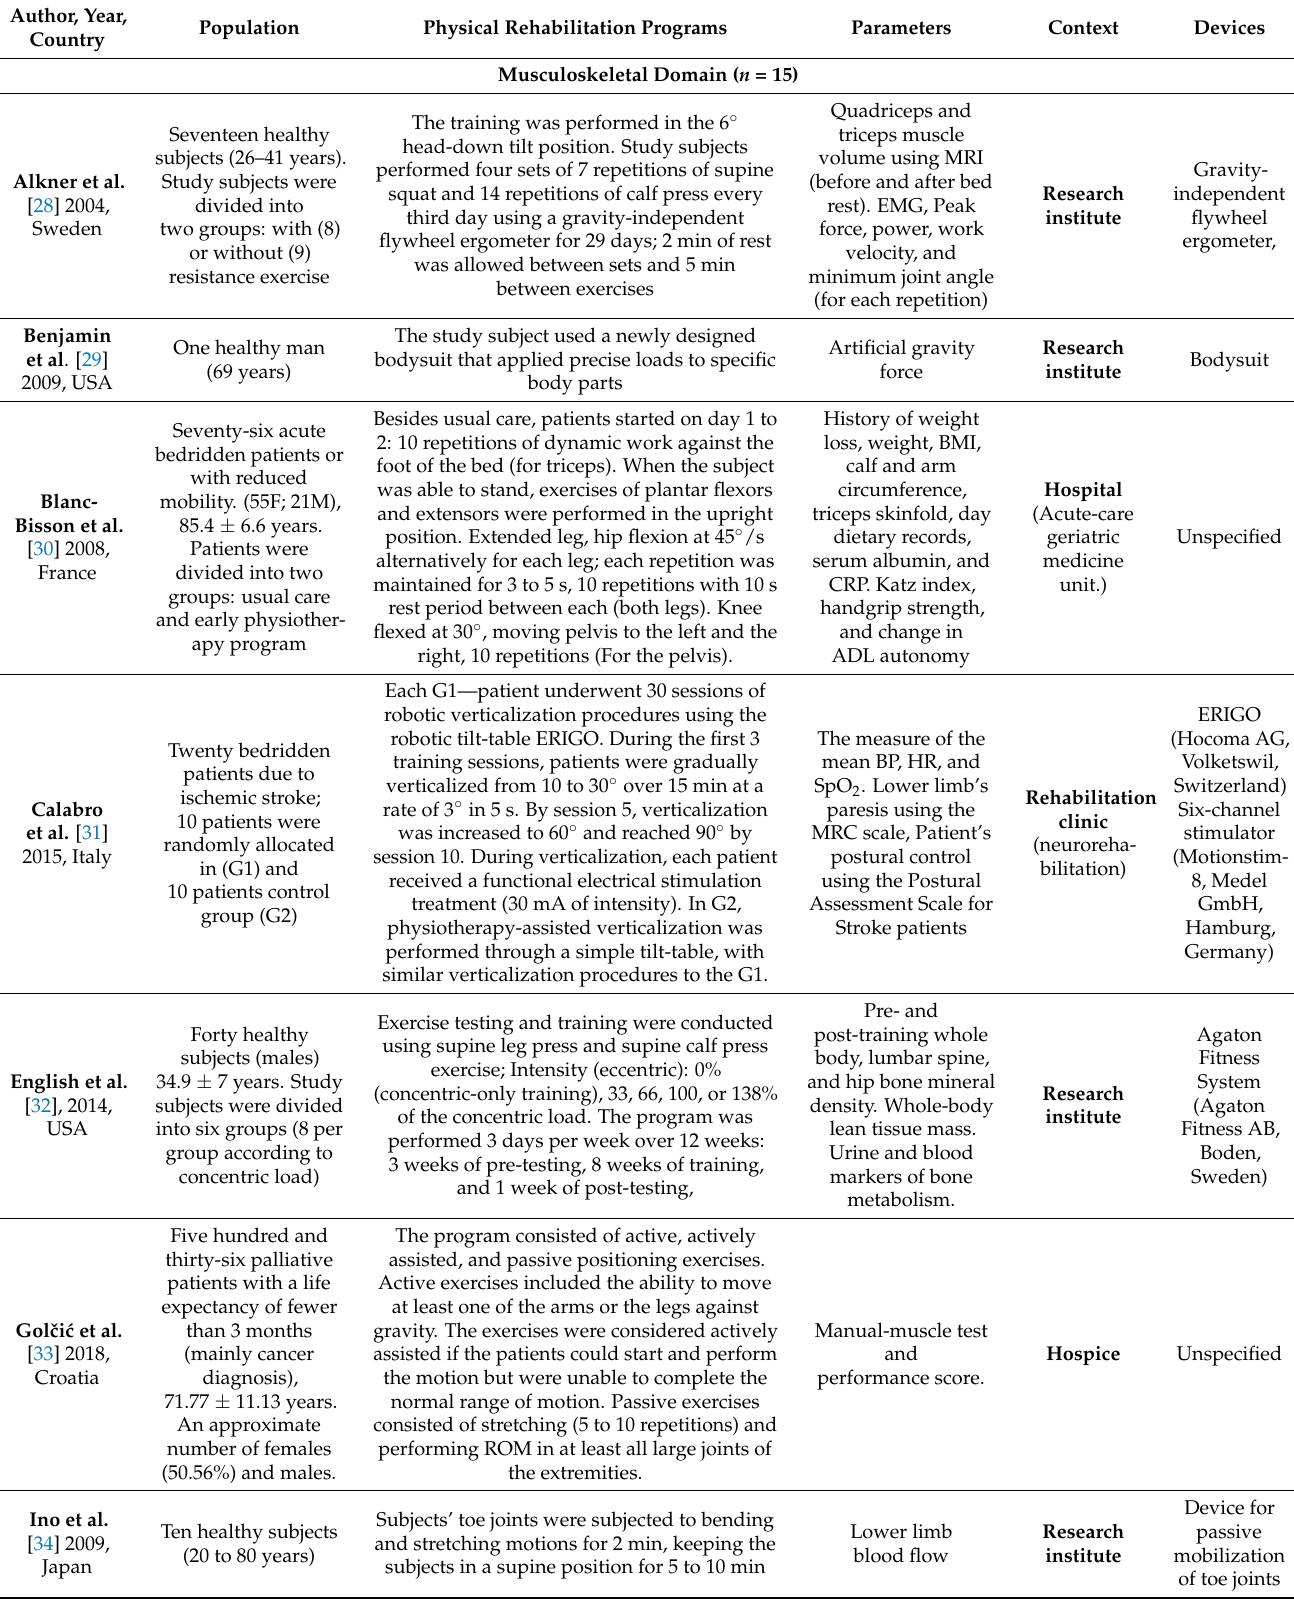
Table 2. Articles including physical rehabilitation programs for bedridden patients with prolonged